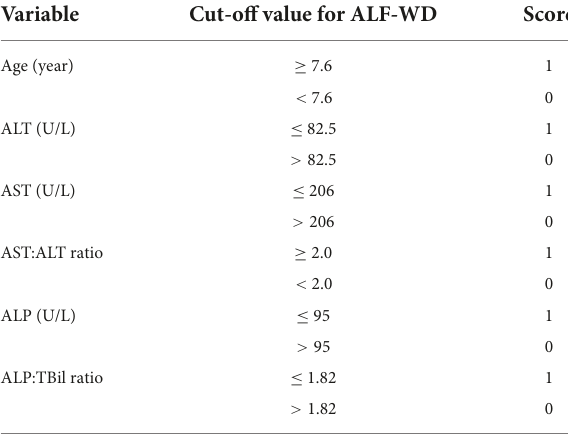
TABLE 6 Scoring system for the diagnosis of ALF-WD. Variable Cut-off value for ALF-WD